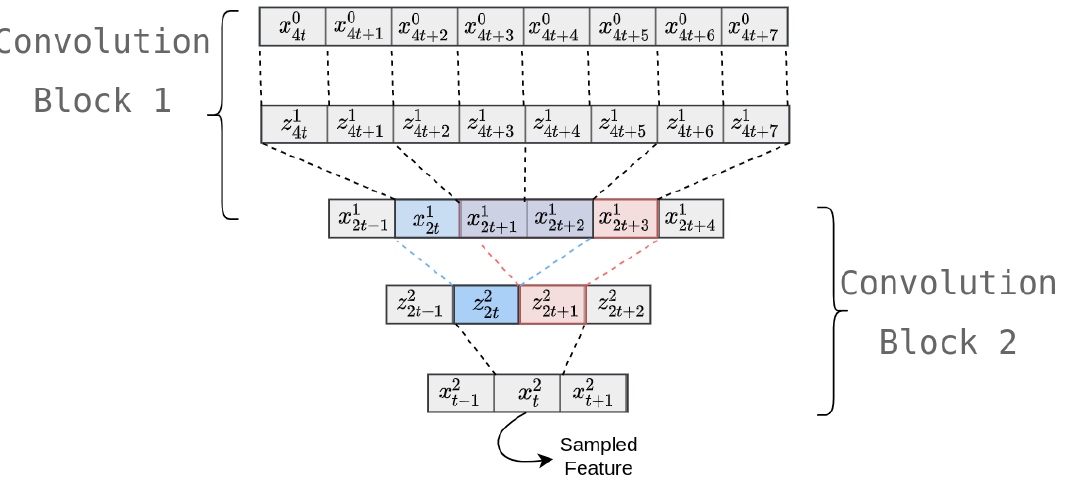
Figure 4. Temporal tracing of a feature of the second convolution block. The indexes correspond to those of Equation (10). The blue and red rectangles express the two different positions of the same convolution kernel of the second convolution block.